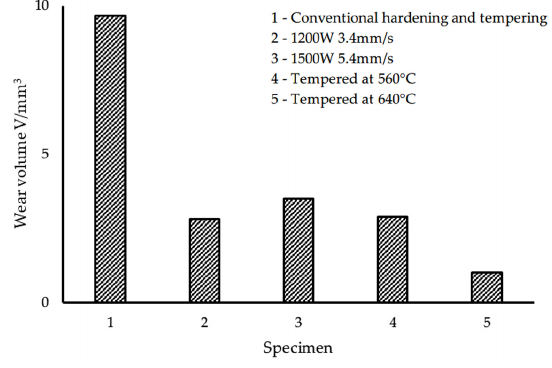
Figure 3. Wear test results of W18Cr4V HSS [42].